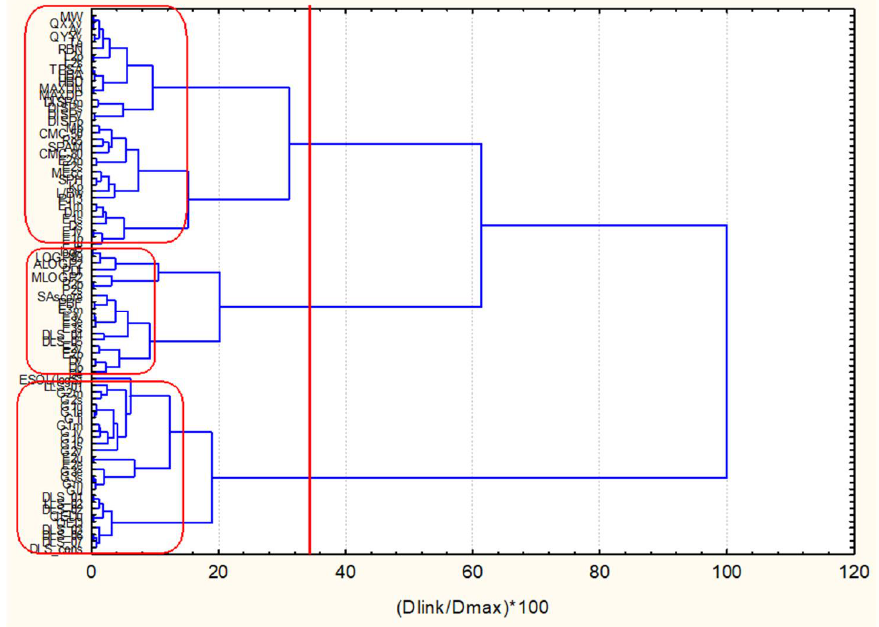
Figure 13. Hierarchical dendrogram for clustering of 83 descriptors.